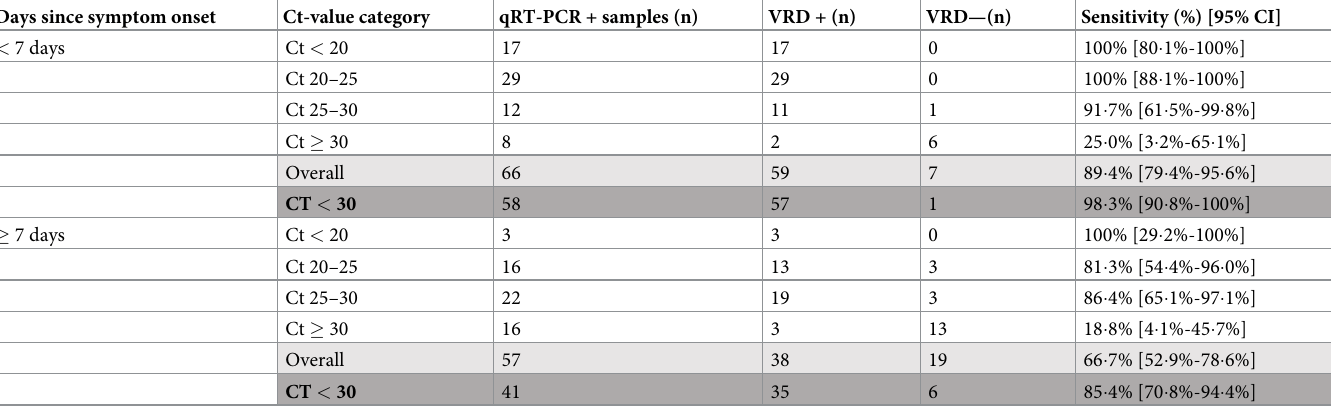
Table 3. Test results of 123 qRT-PCR positive specimen of symptomatic individuals from study part two. Days since symptom